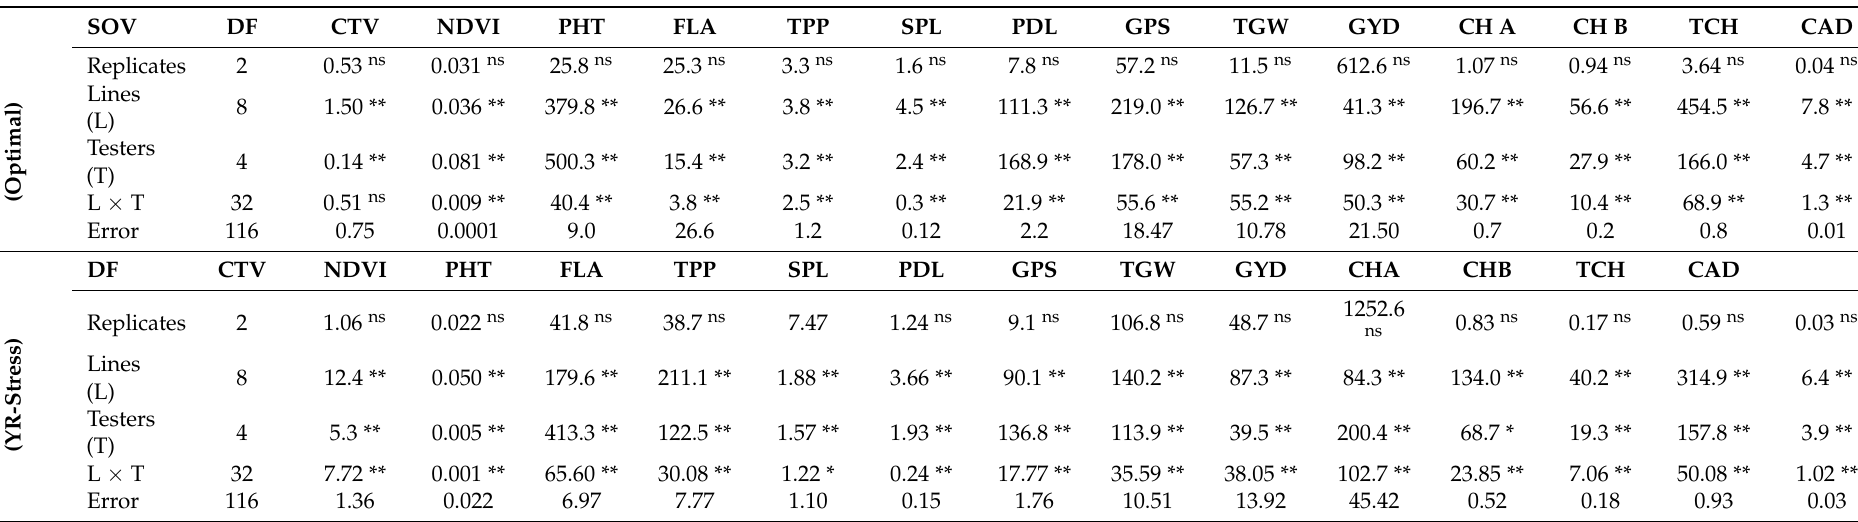
Table 3. Analysis of variance for physiological, yield and yield components, bio-chemicals traits under optimal and YR-stress